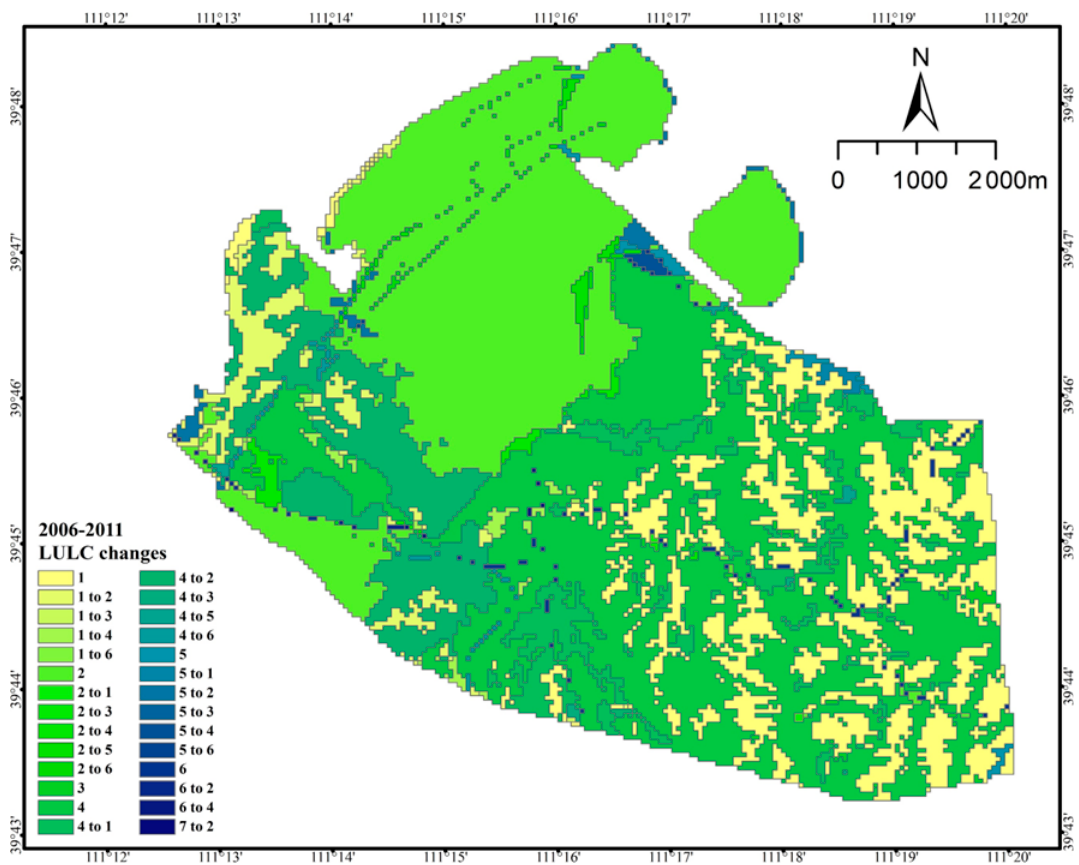
Figure 4. Land use/land cover type change from 2006 to 2011 (1. Cropland; 2. Industrial and mining land; 3. Forest; 4. Residential land; 5. Grassland; 6. Transportation land; 7. Waterbody). The area of grassland increased by 0.32% from 2011 to 2016, mainly from waste dumps and other mining sites, with areas of 17.60 hm 2 and 15.75 hm 2 , respectively. The area of cultivated land increased by 7.13%, mainly from forest. The area of open quarry increased by 4.30%, mainly from 346.51 hm 2 of waste dump and 351.76 hm 2 of forest. The area of other industrial and mining land increased by 3.41%. In five years, the area of industrial and mining land (open-pit quarries, waste dumps, and other industrial and mining land) encroaching on grassland was 23.47 hm 2 . The area of industrial and mining land converted to grassland was 33.97 hm 2 . An area of 432.99 hm 2 of forest was converted to industrial and mining land. The area of cropland converted to forest was 467.27 hm 2 (Table 3, Figure 5).